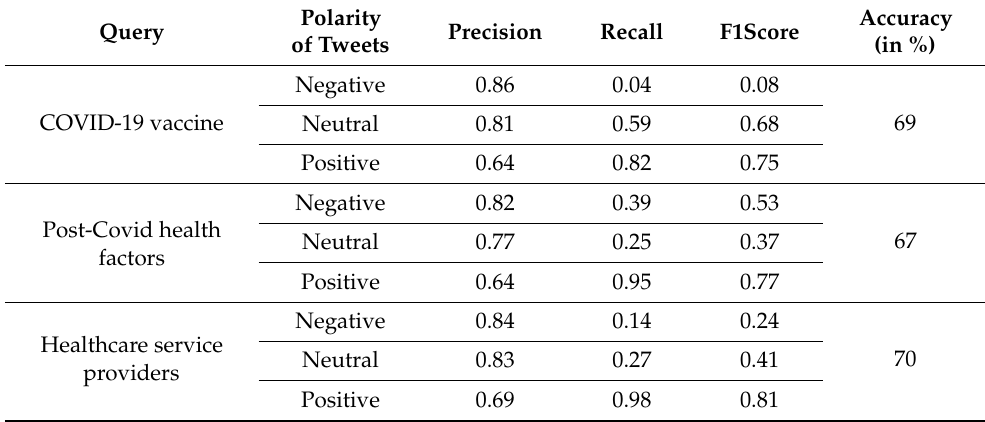
Table 7. Multinomial naïve Bayes model evaluation results for all three considered